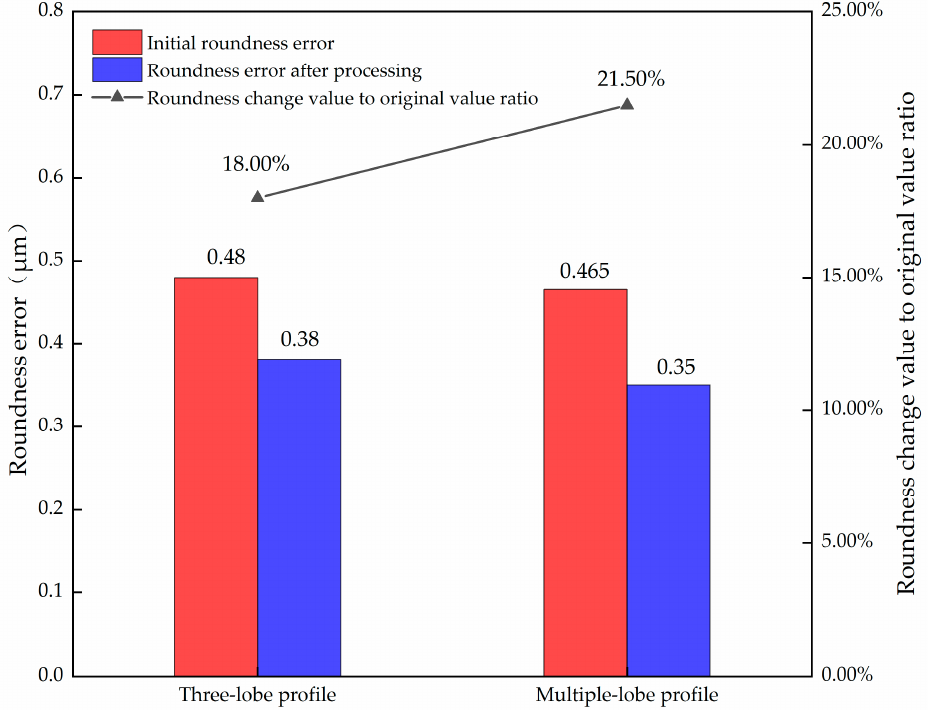
Figure 9. Comparison of roundness after processing between three-lobe profile and multiple-lobe profile.